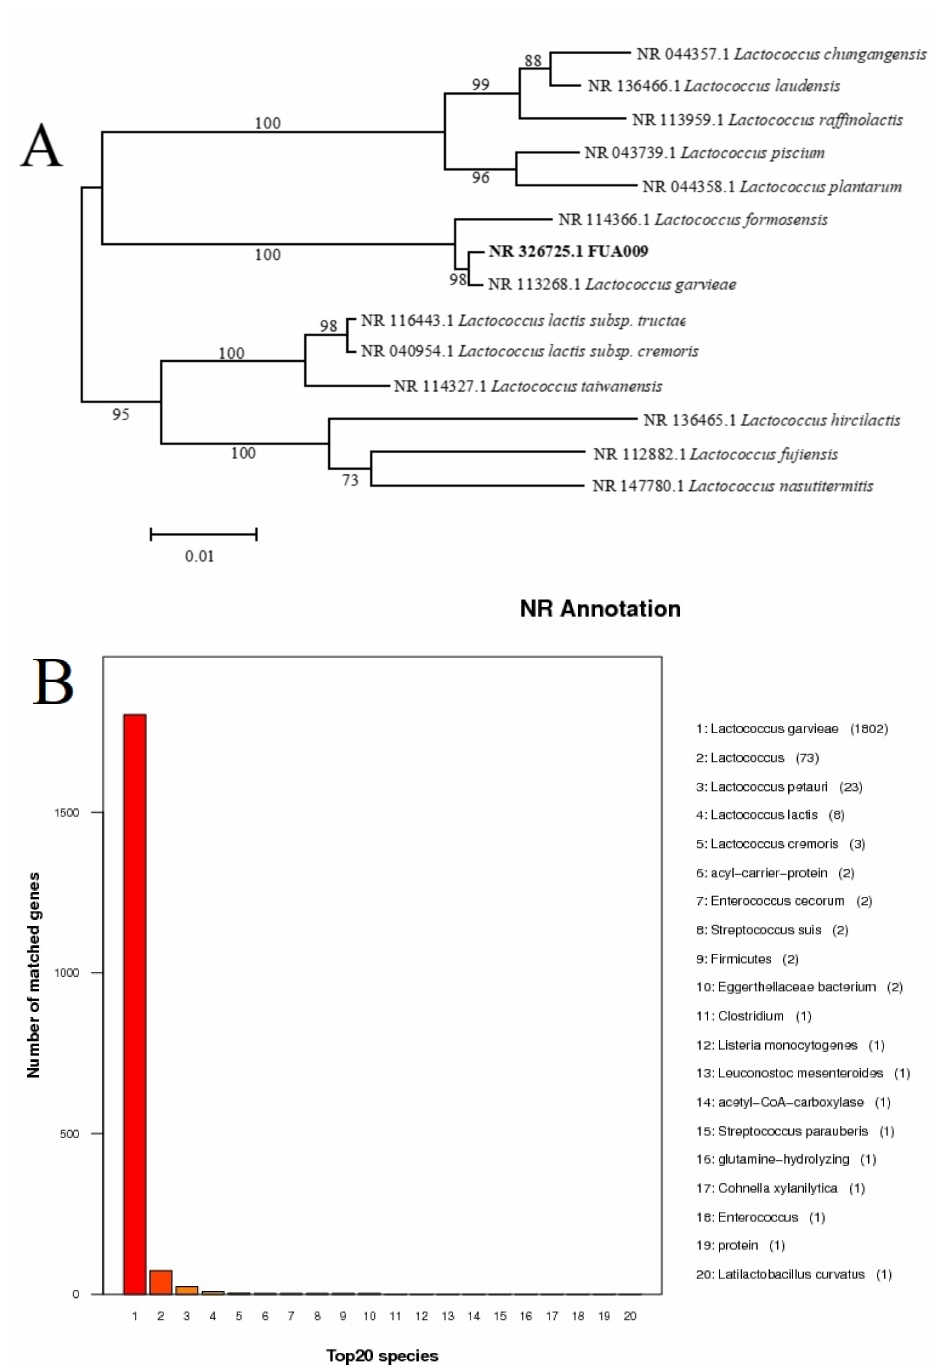
Figure 2. FUA009 was assigned to the species Lactococcus garvieae . ( A ) Phylogenetic tree showing the relationships between the Lactococcus garvieae FUA009 and other representatives of the family Lactococcus . The tree was constructed by using the neighbor-joining method based on 16S rRNA gene sequences. The distance matrix was calculated using the Jukes and Cantor method. Bar: 1% nucleotide sequence difference. Numbers at nodes ( ≥ 70%) indicate support for internal branches within the tree obtained using bootstrap analysis (percentages of 500 re-samplings). ( B ) The species annotation results of Lactococcus garvieae FUA009 in the Non-Redundant Protein